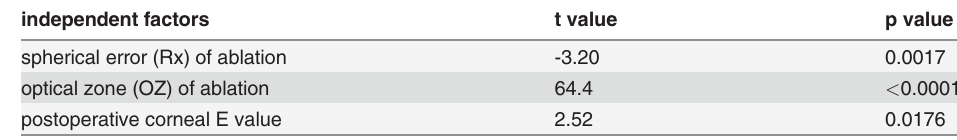
Table 4. Multiple stepwise regression analysis for the measured area of wavefront